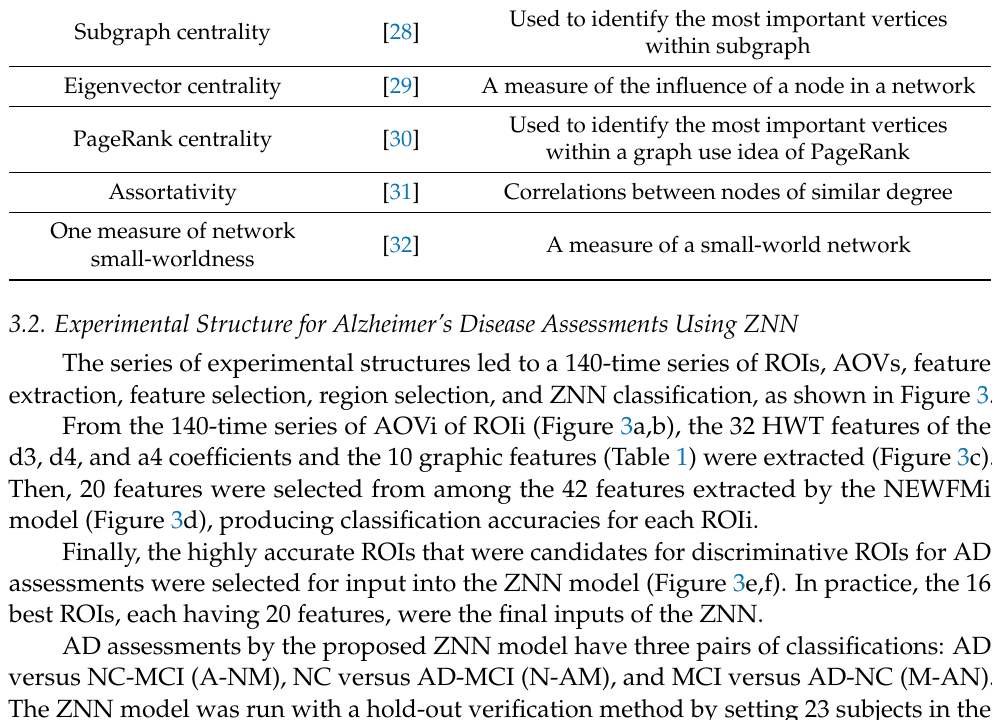
algorithm with the discriminative regions of interest in the Anatomical Automatic Labeling (AAL-90) model.